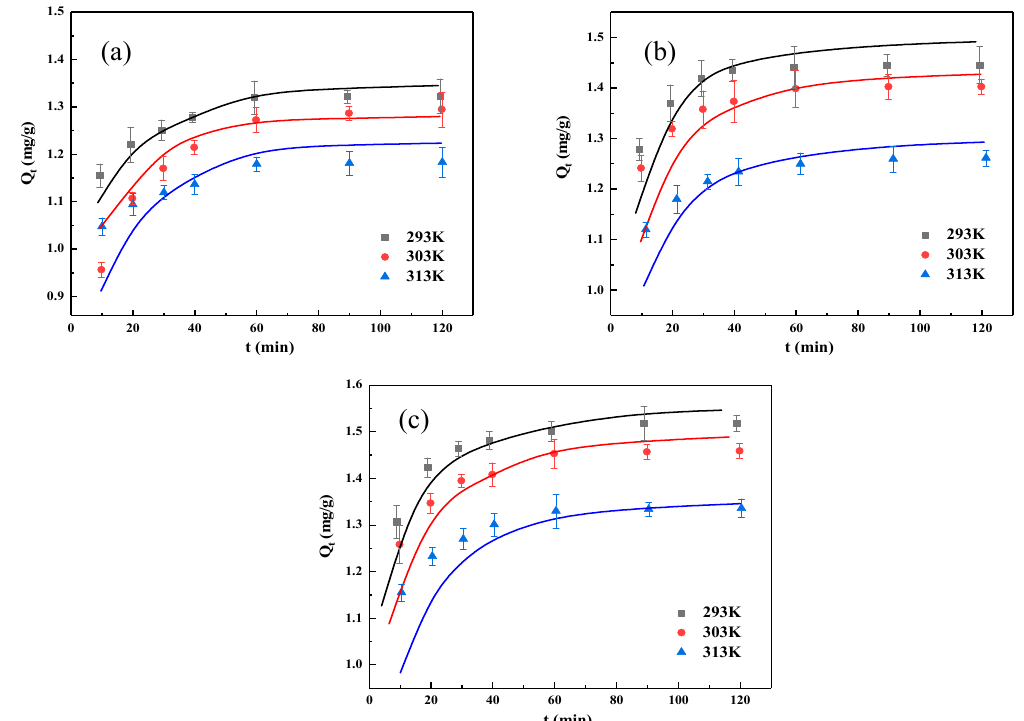
Figure 7. The effect of contact time on the adsorption capacity of coke powder for quinoline with ( a ) no inorganic ions, ( b ) K + , and ( c ) Ca 2+ (experimental data points given by symbols and the lines predicated using the pseudo-second-order model; the error bars represent the standard deviation calculated on the basis of the adsorption tests performed in triplicate in this study).